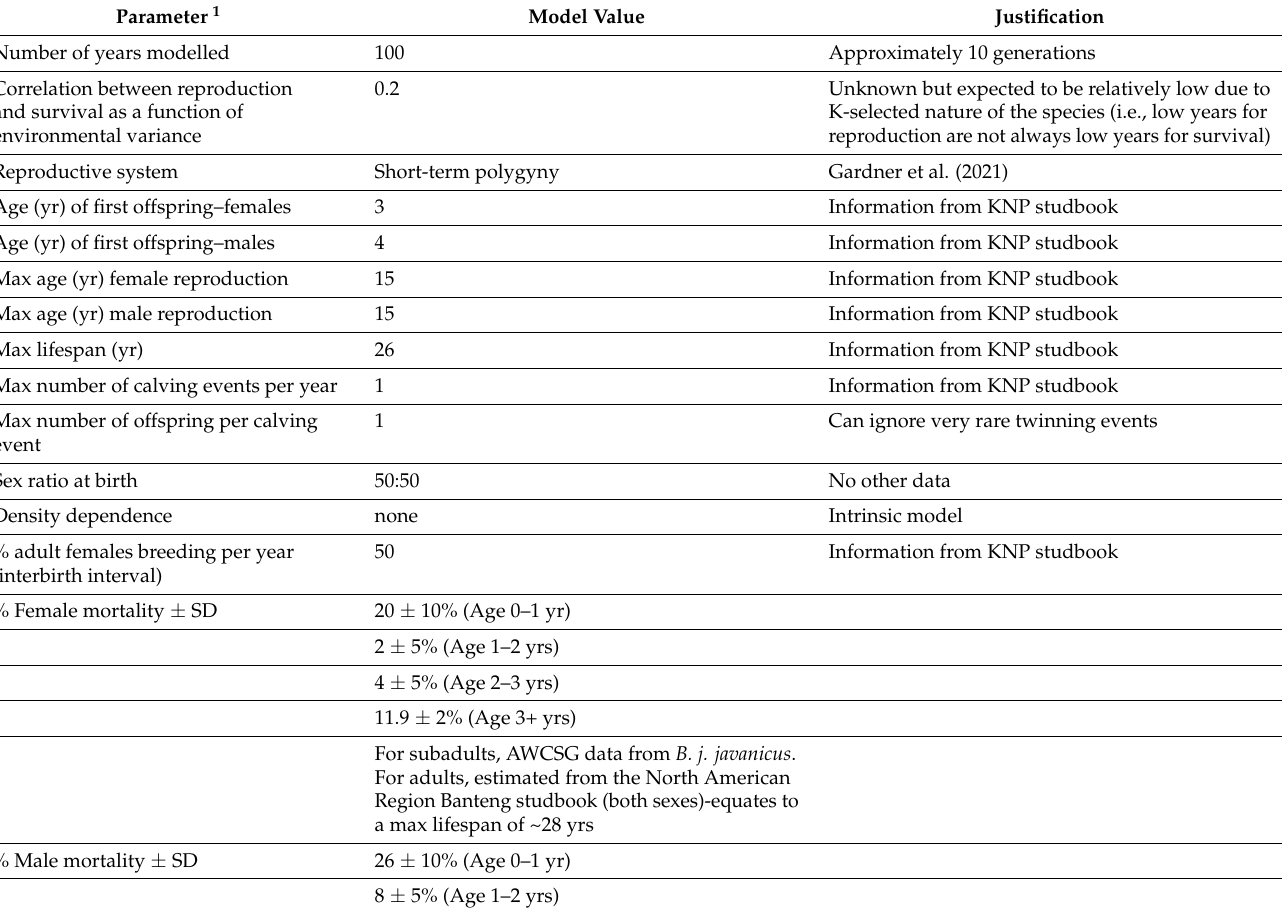
Table 2. Population parameters for bantengs in Khao Nam Phu Nature and Wildlife Education